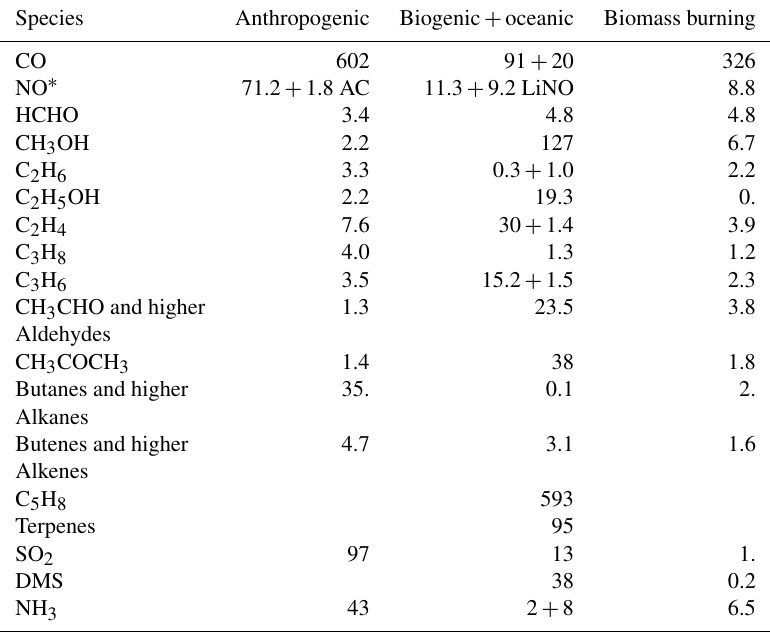
Table 2. Specification of annual emission totals from anthropogenic, biogenic and natural sources, and biomass burning for 2011, in tetra- grams of species mass, for three chemistry versions.